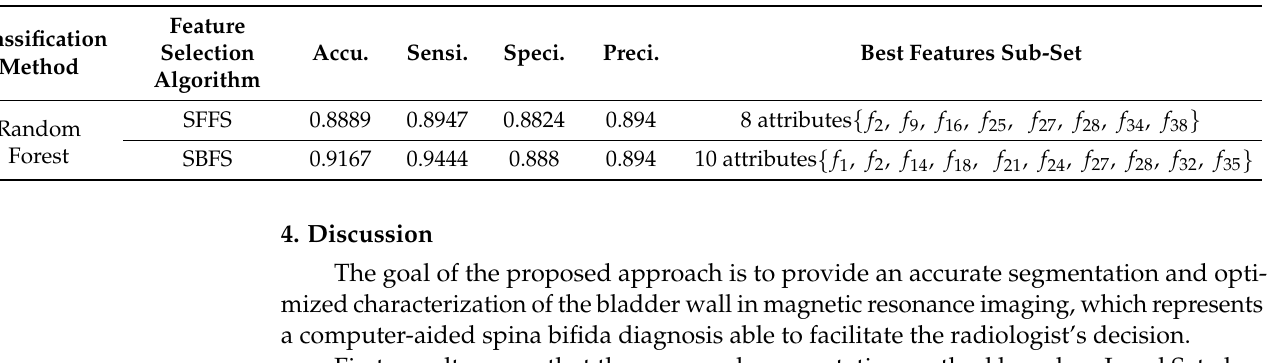
Figure 9. Random forest classification accuracy score according to the sub-vector of tested features using SBFS algorithm. Red lines indicate the best performance achieved.